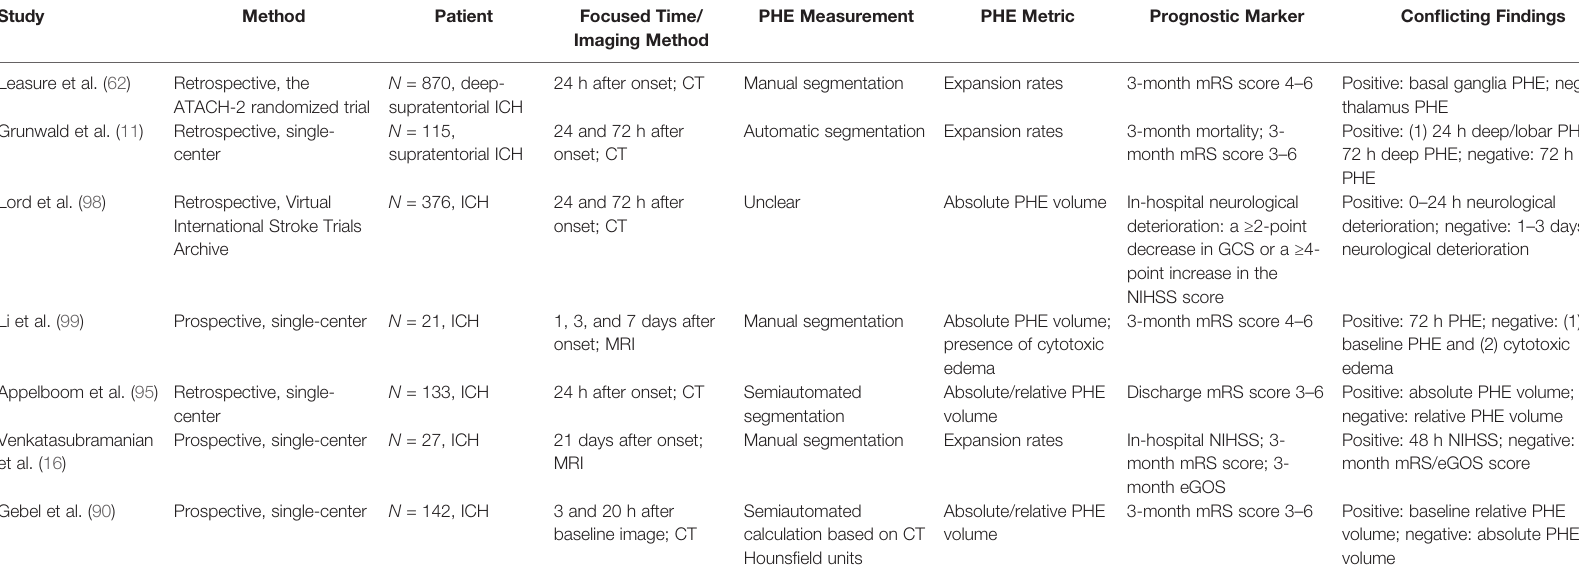
TABLE 4 | Summary of prognostic research of PHE — the con fl icting fi